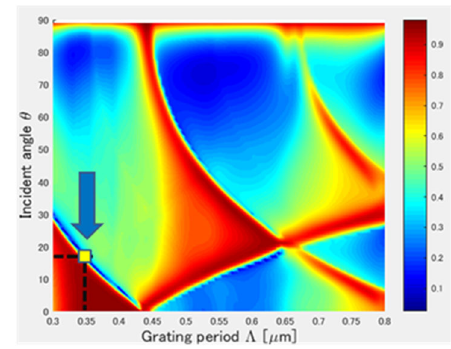
Fig. 3. Reflectance color